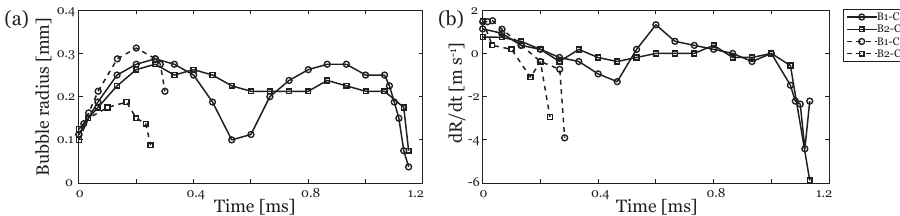
Figure 10. ( a ) Bubble radius. ( b ) Bubble dR / dt . Two bubbles were measured (B1, B2) during initial growth and collapse (C1) and first rebound and collapse